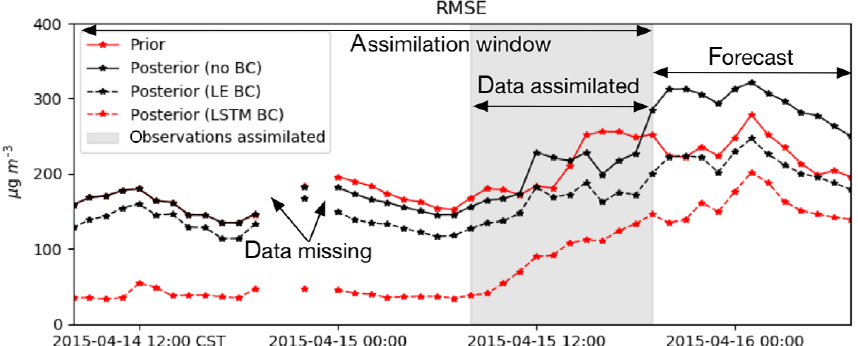
Figure 10. Time series of root-mean-square error compared to the ground PM 10 . The assimilation window is set from 14 April at 08:00 to 15 April at 19:00, and PM 10 observations in the gray shaded area are assimilated.